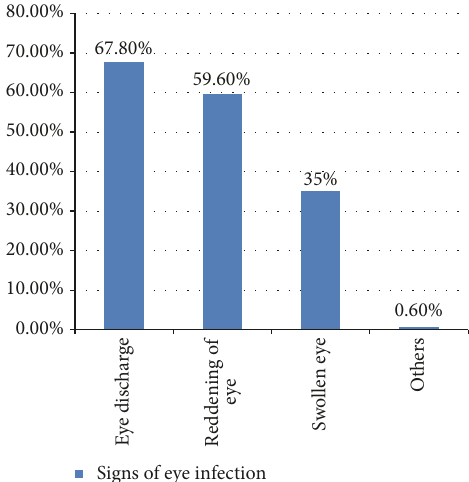
Figure 5: Knowledge of postnatal mothers’ on sign of eye infection in Addis Ababa health centers, Dec.1-Jan. 30,